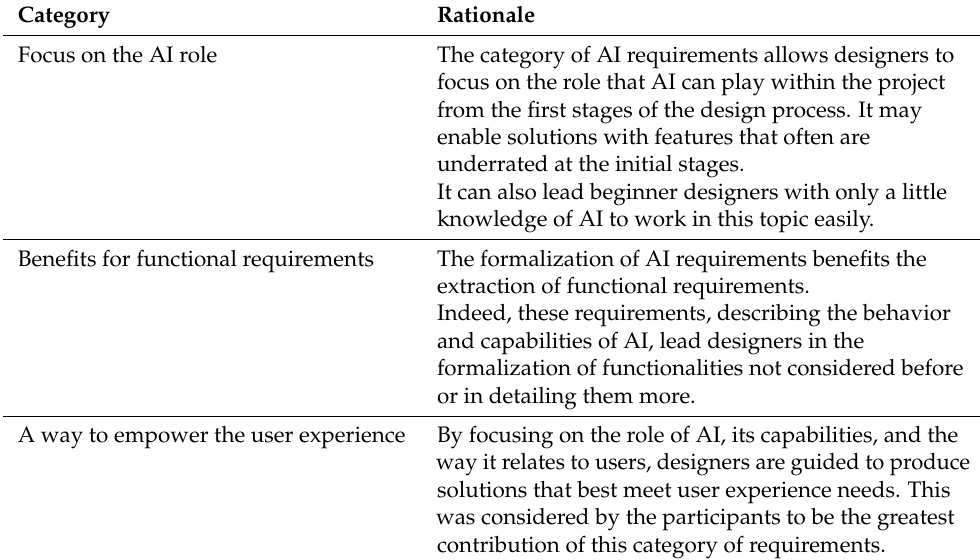
Table 2. The three main themes brought out by the student project